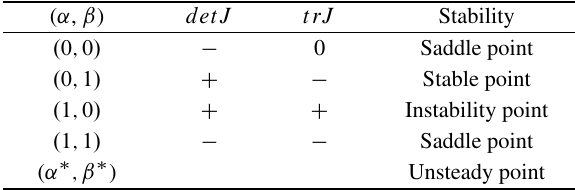
Table 4 Stability of equilibrium points in Scenario